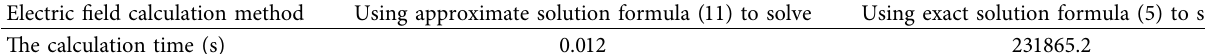
Table 1: Comparison of calculation time between approximate and accurate solutions.